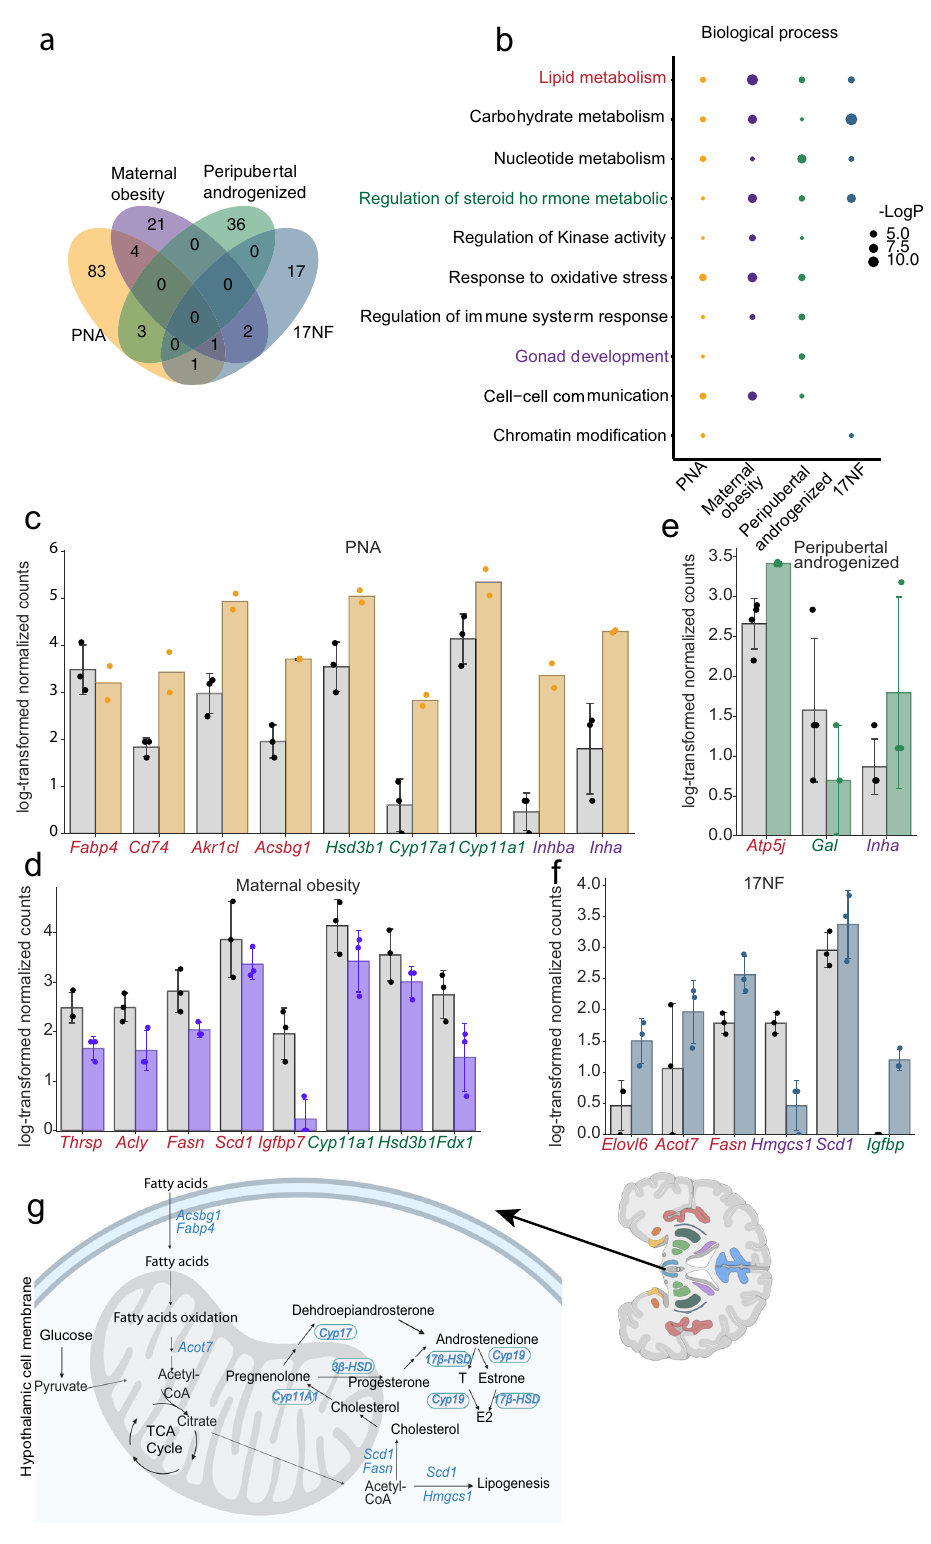
Fig. 2 Common and distinct transcriptomic signature of the hypothalamus. a Venn diagram of DEGs across all animal models (PNA model, n = 3 in control + vehicle, n = 2 in prenatal DHT; maternal obesity, n = 3 in control, n = 3 in maternal obesity; Peripubertal androgenized model, n = 4 in control + vehicle, n = 3 in Peripubertal DHT; 17NF, n = 3 in control, n = 3 in 17NF). b Comparison of enriched gene ontology terms of DEGs across all animal models. c – f Bar plot showing expression level of DEGs enriched in lipid metabolism, steroid hormone metabolism, and gonad development in PNA, Peripubertal androgenized, 17NF, and maternal obesity, respectively. g Illustration of DEGs involved in lipid and steroid metabolism pathways in hypothalamus (Created with BioRender.com). Data are presented as mean ± SD. n number of